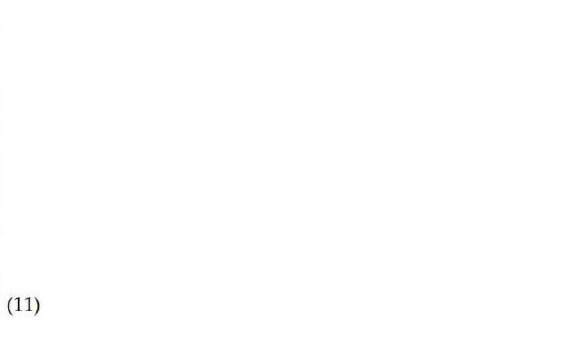
Figure 2. Illustration of varieties and germplasm lines used in field trials (1—BEW, 2—JC1, 3—PI